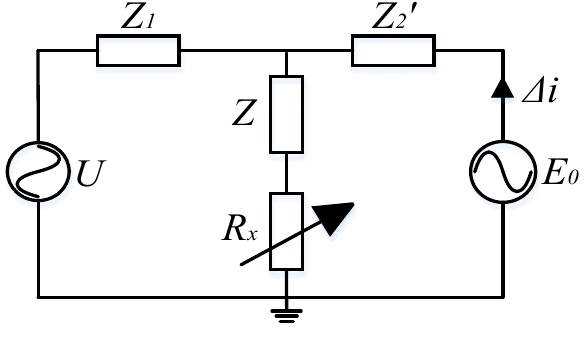
Figure 5. Simplified model for the online detection of transformer insulation.